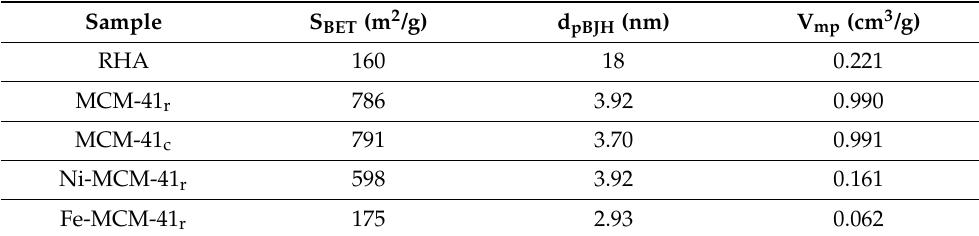
Table 2. Textural parameters of RHA and silica materials.